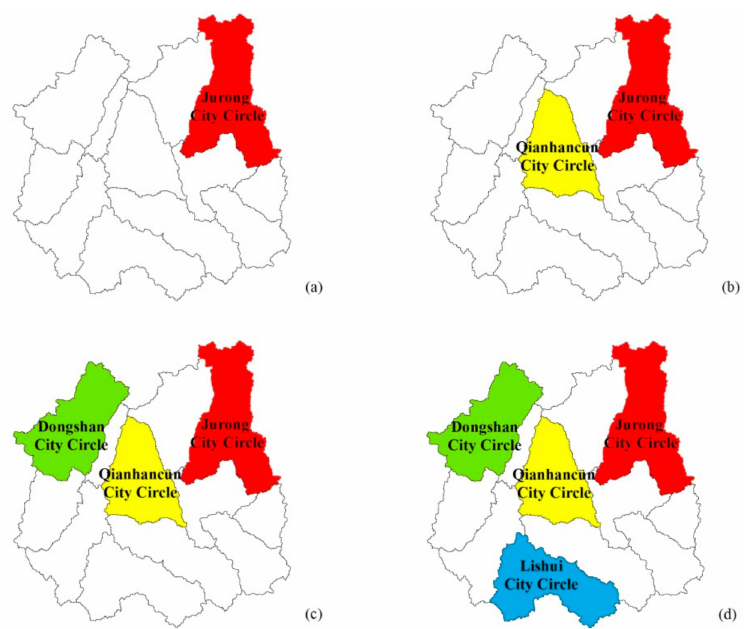
Figure 9. The map of polder distribution: ( a ) Jurong City Circle only; ( b ) Jurong City Circle in the upper reach and Qianhancun City Circle in the middle reach; ( c ) Jurong City Circle in the upper reach, Qianhancun City Circle in the middle reach, and Dongshan City Circle in the lower reach; ( d ) Jurong and Lishui City Circle in the upper reach, Qianhancun City Circle in the middle reach, and Dongshan City Circle in the lower reach.